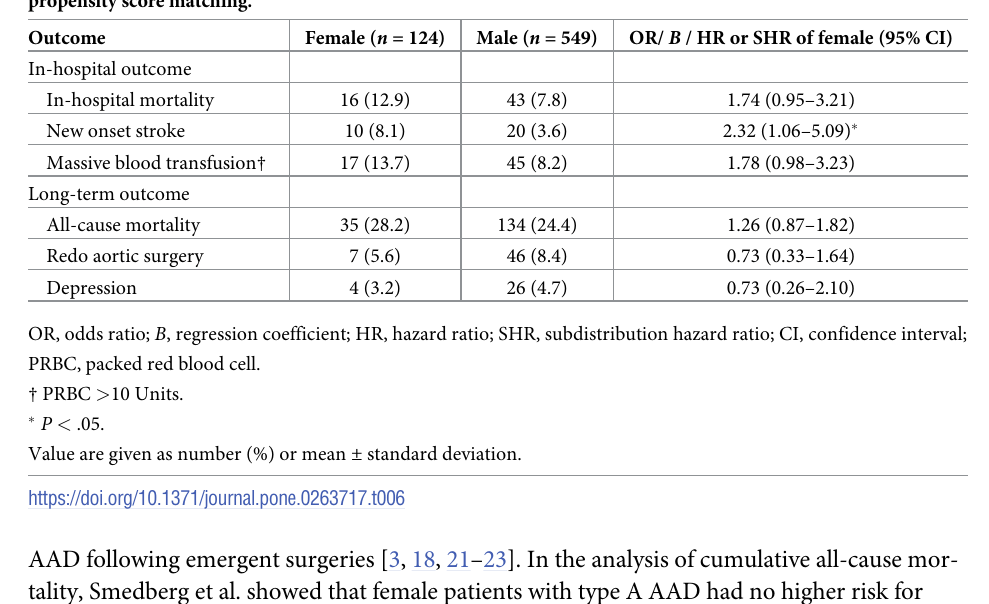
Table 6. In-hospital and long-term outcomes of the female versus male patients with type B stent surgery before propensity score matching. Outcome Female ( n = 124) Male ( n = 549)